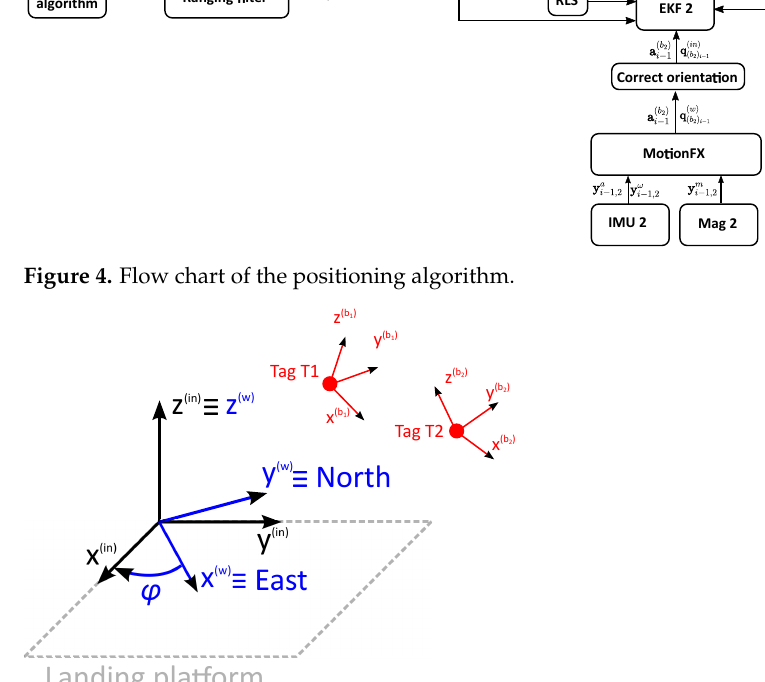
Figure 5. Body, world and inertial frames. Each tag contains an independent body frame, ( b 1 ) and ( b 2 ) , which are fixed to the sensors. All measurements of the IMUs and magnetometers and the resulting